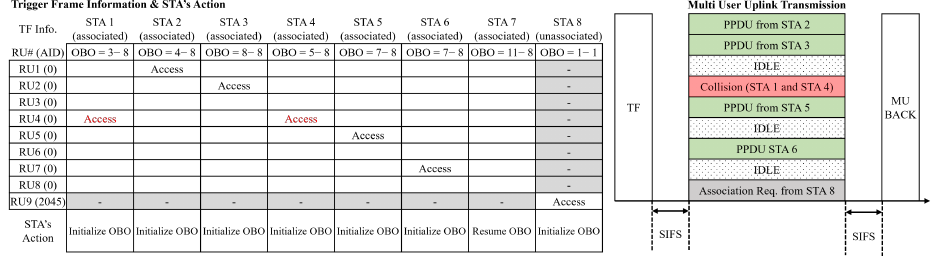
Figure 1. An example of a UORA operation in the IEEE 802.11ax